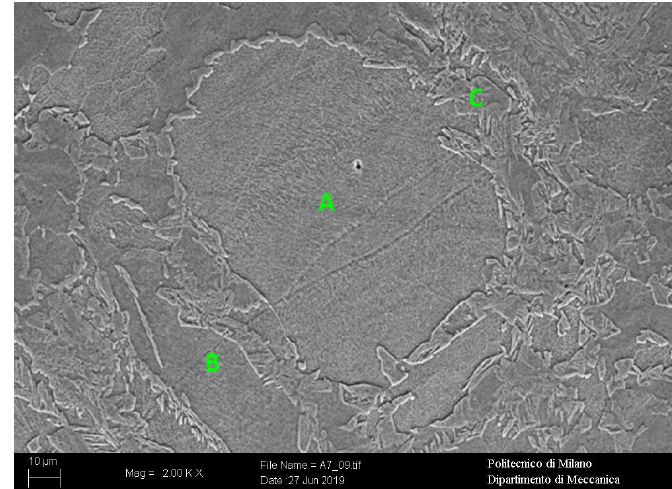
Figure 10. Melt pool SE image. Table 4. EDS analysis of the melt pool in the zones remarked in Figure 10.